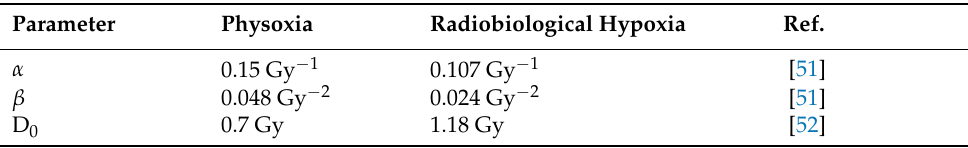
Table 3. Parameters used for the cells survival probability